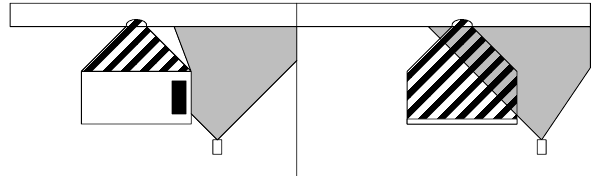
Figure 8: Left: The car is blocking the camera from seeing the blind spot on the wall. Right: The lack of depth on the car enables the camera to see the blind spot.